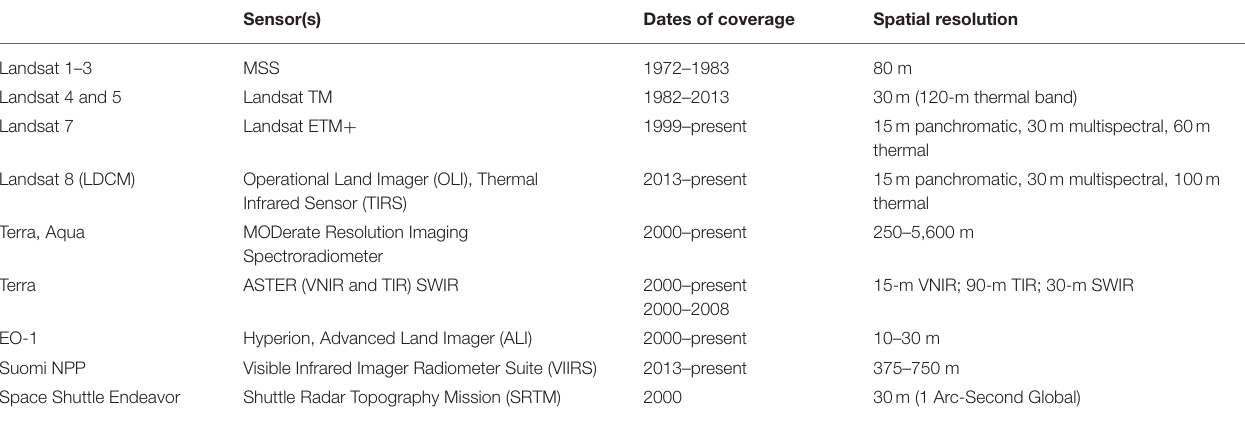
TABLE 1 | Satellite data sources utilized for the